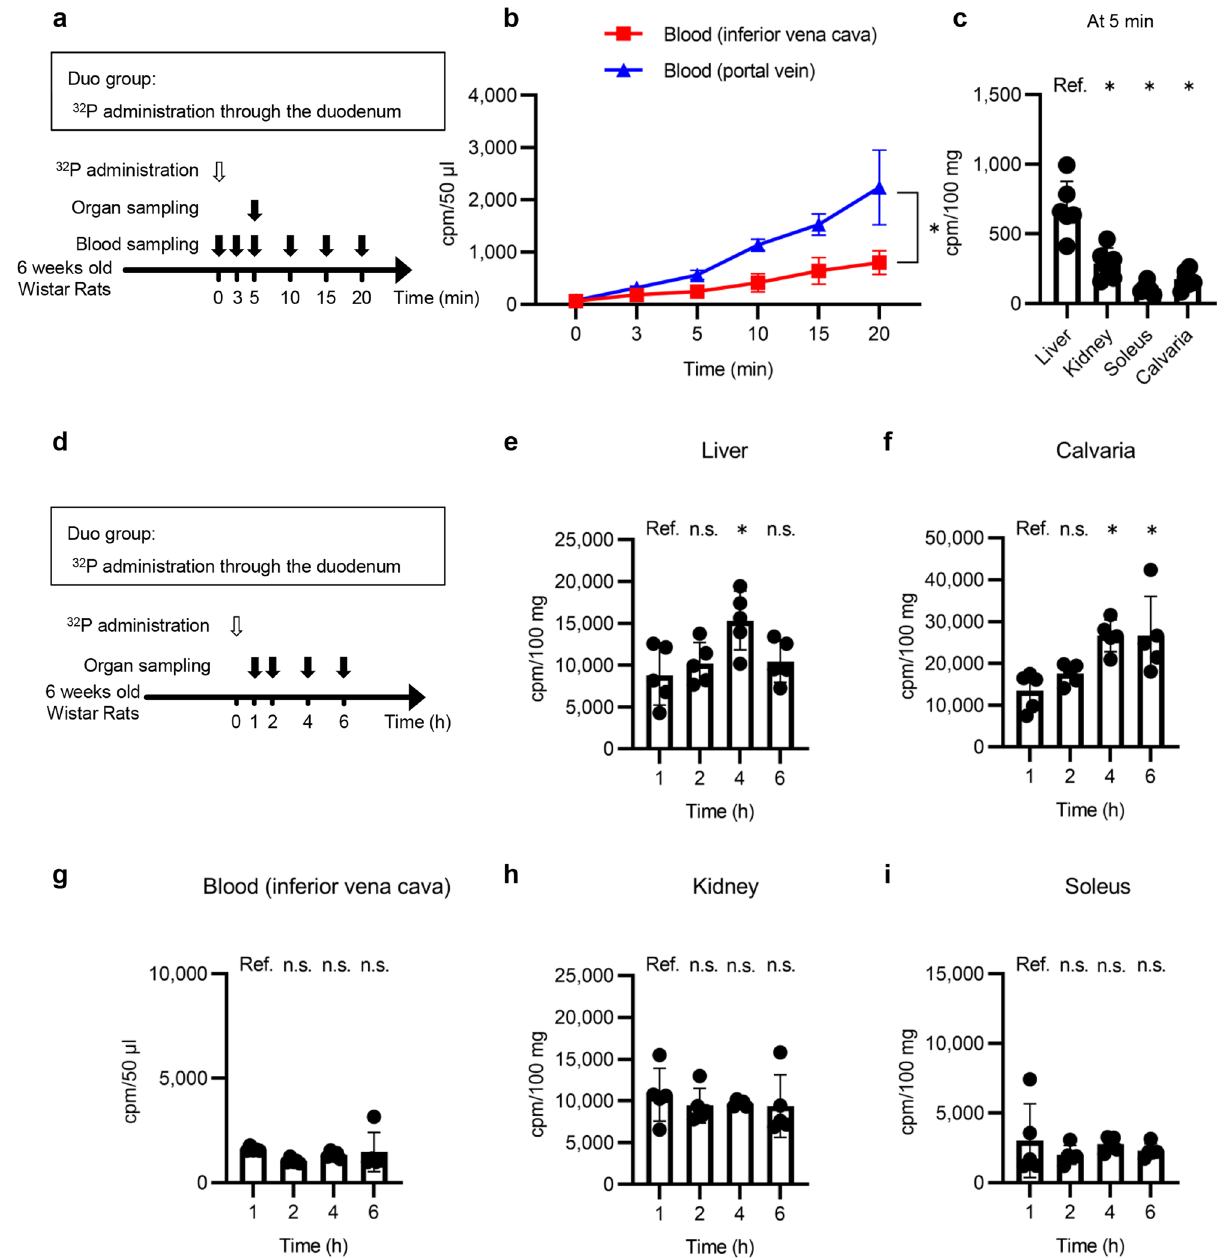
Figure 1. Phosphate kinetics in rats after phosphate administration through the duodenum. ( a ) Experimental design of ( b ) and ( c ). The effects of duodenal administration of phosphate on normal rats (Duo group) were analyzed. A Na 2 HPO 4 /NaH 2 PO 4 solution (phosphate 80 mM, sodium 154 mM, pH 7.4, 1.0 ml/animal) containing trace amounts of radiolabeled phosphate ( 32 P, 3700 Bq/ml) was administered through the duodenum at time 0. Blood samples were collected from the inferior vena cava and portal vein at the indicated time points. Organ samples were collected at 5 min. ( b ) 32 P levels (counts per minute (cpm)) in the blood of the inferior vena cava and portal vein (n = 4 rats per group). ( c ) 32 P levels in the liver, kidney, soleus, and calvaria at 5 min (n = 6 rats per group). ( d ) Experimental design of ( e ) to ( i ). The radiolabeled sodium phosphate solution was administered in the same manner as in ( a ). Levels of 32 P in the ( e ) liver, ( f ) calvaria, ( g ) blood from the inferior vena cava, ( h ) kidney, and ( i ) soleus were measured at the indicated time points (n = 5 rats per group). All results are presented as the means ± SDs, n.s.: not significant, Ref.: reference. * P < 0.05 based on the repeated measures of ANOVA in ( b ) and on Dunnett’s test in ( c ) and ( e ) to ( i